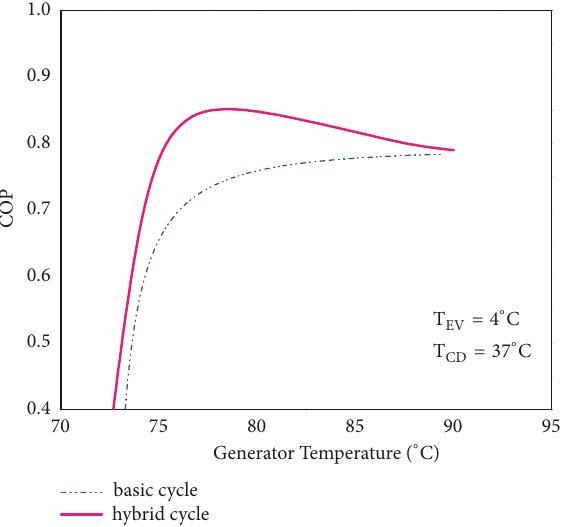
Figure 7: 𝐶𝑂𝑃 of hybrid and conventional cycle vs . condenser temperature, 𝑇 𝐶𝐷